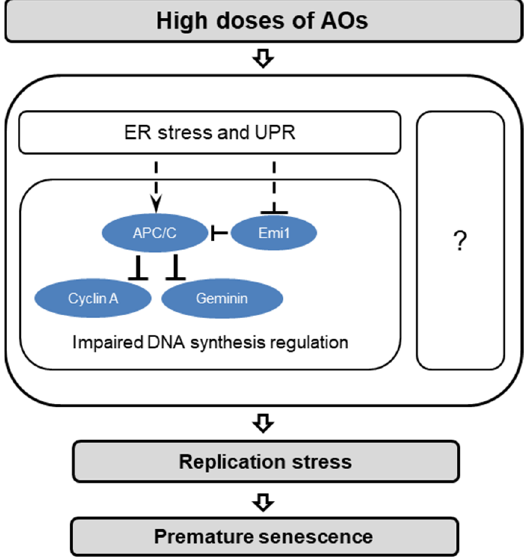
Figure 8. Effects caused by high-dose AO treatments. AO-induced stress can cause ER stress which is accompanied by disturbances in DNA synthesis regulation associated with the timeless activation of the APC/C ubiquitin ligase complex. The logic flow of the events (marked with dashed arrows) is hypothetical and based on the previously published data. A detailed description of the effects marked with grey panels can be found in [25]. The effect of AO-induced activation of APC/C marked with blue panels is discussed in [14].